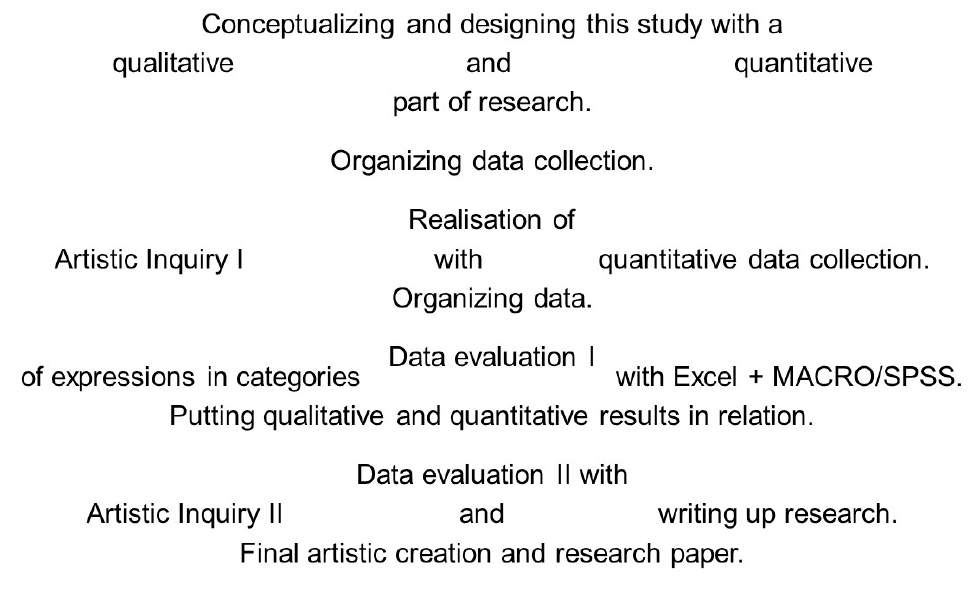
Figure 2. Process model of the study.